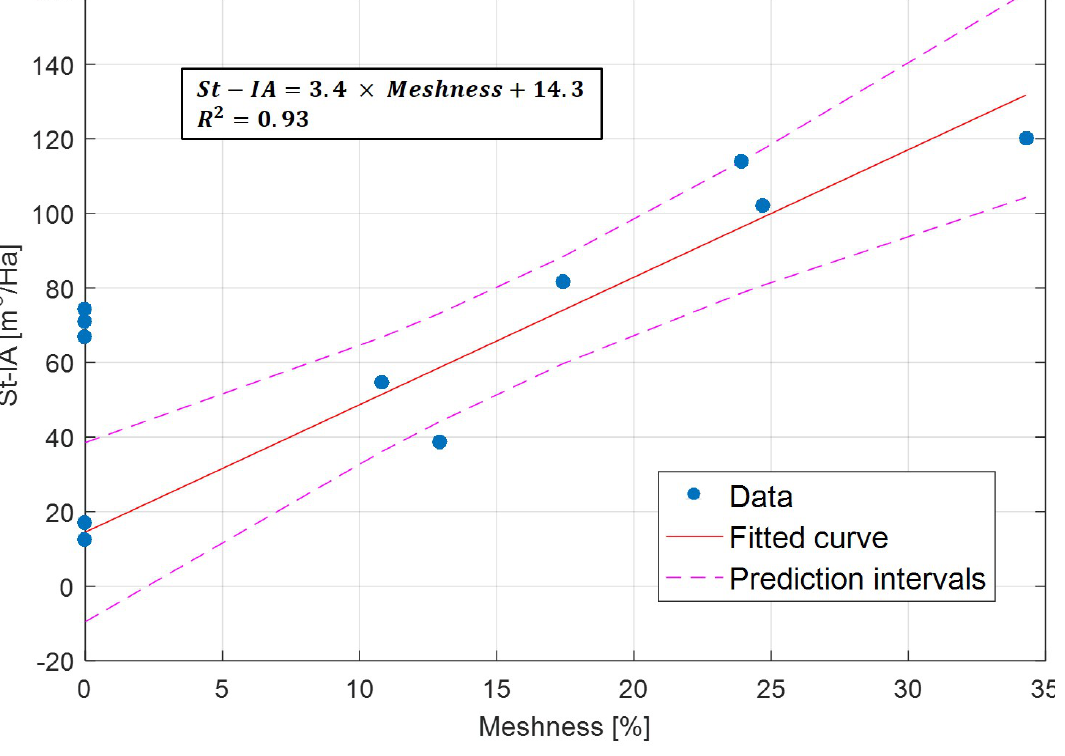
Figure A1. Relationship between total sewer storage capacity (St-IA) and Meshness; including fitted lines, their 95% confidence intervals (red and magenta lines respectively) and fitted